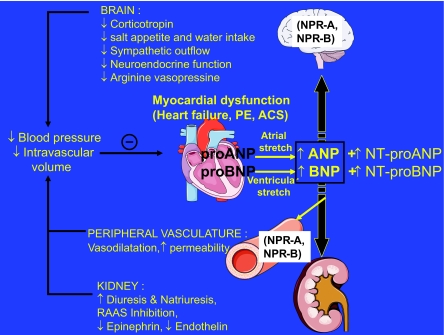
Physiologic actions of BNP.